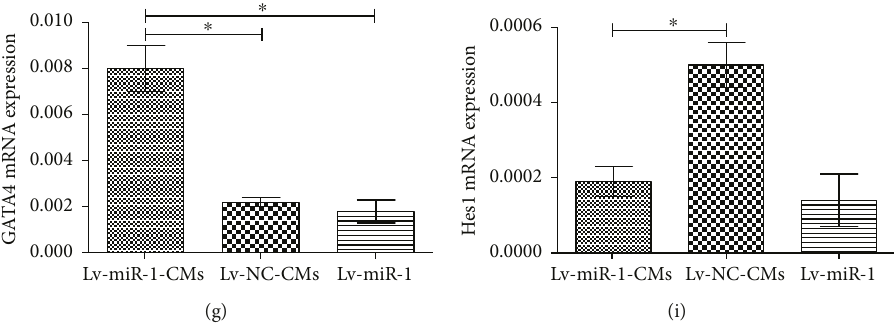
Figure 5: Expression levels of Notch1, Hes1, cTnI, and GATA4 proteins in ASCs after coculture with CMs. Three groups of 3rd-generation lentivirus (Lv)-infected ASCs were examined as follows: (1) Lv-miR-1-CMs (miRNA-1-expressing cells cocultured with CMs), (2) Lv-miR-1 (miRNA-1-expressing ASCs), and (3) Lv-NC-CMs (control infected ASCs cocultured with CMs). (a) Western blot analysis of the indicated proteins. GAPDH was used as normalization control. (b – e) Quanti fi cation of cTnI, GATA4, Notch1, and Hes1 protein levels, as indicated. (f – i) mRNA expression levels of cTnI, GATA4, Notch1, and Hes1, as indicated. ∗ P < 0 05 and ∗∗ P < 0 01